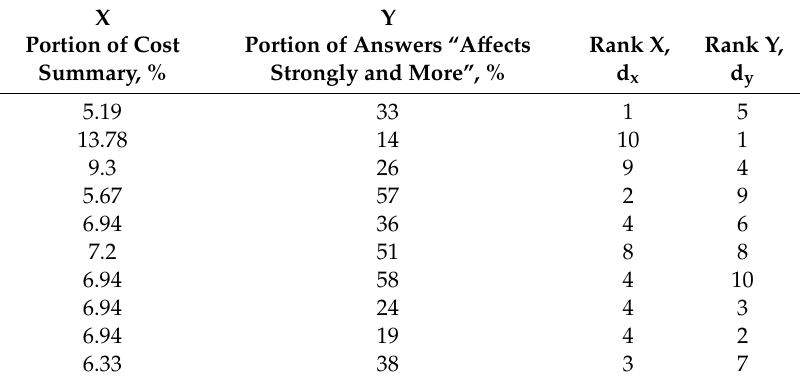
Table 6. Ranking by Y and factor X.